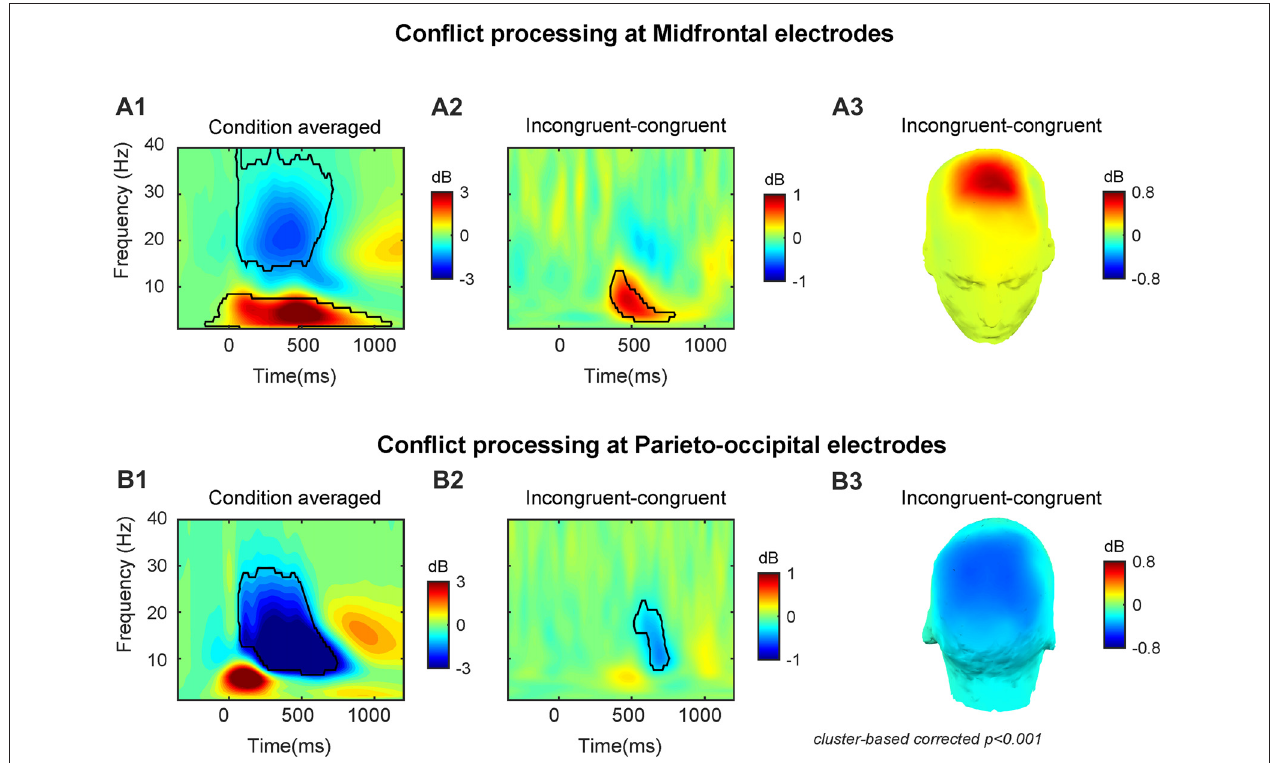
FIGURE 2 | Conflict processing reflected in neural oscillations at midfrontal and parieto-occipital electrodes. The time-frequency (TF) power dynamics plots for (A1) condition averaged and (A2) the conflict effect, and (A3) topographic plots of the conflict effect at midfrontal electrodes. The TF power dynamics plots for (B1) condition averaged and (B2) the conflict effect neural oscillations and (B3) topographic plots of the conflict effect at parieto-occipital electrodes. Time 0 is the onset of target facial expression. The TF region encircled by the black solid line is statistically significant at p < 0.001 (corrected for multiple comparisons using cluster based statistics). Panels (A3,B3) were plotted using the averaged data enclosed area in panels (A2,B2)